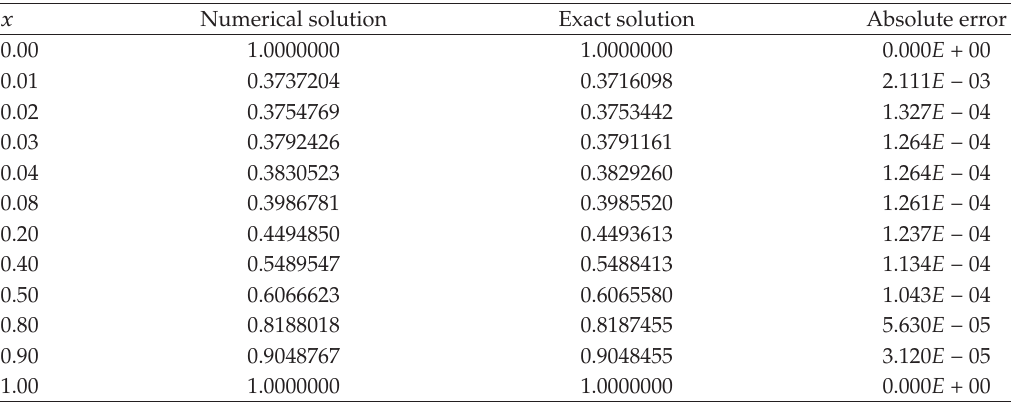
Table 3: Numerical results of Example 4.1 for ε (cid:8) 0 . 0001 , δ (cid:8) 0 . 00001, N (cid:8)